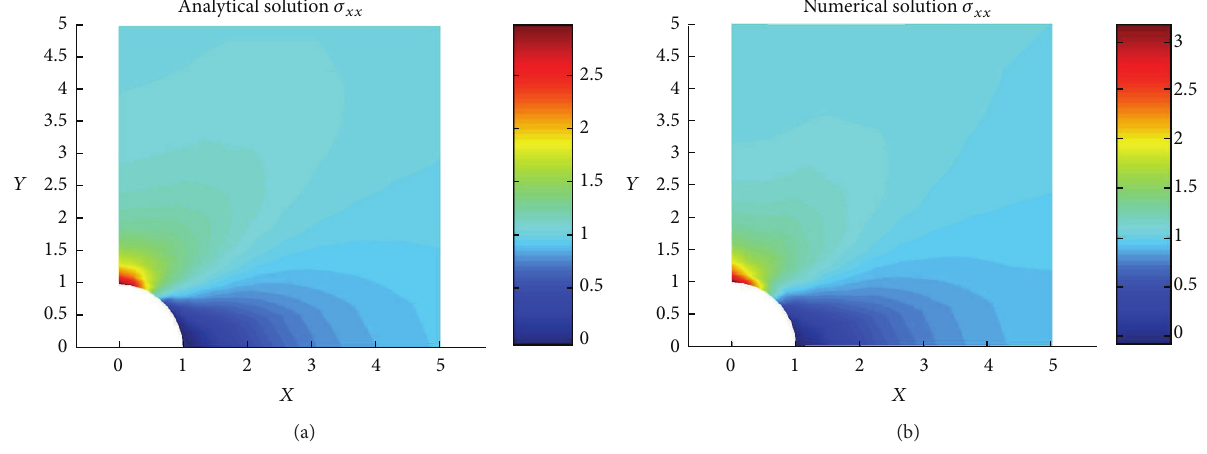
Figure 13: Stress 𝜎 𝑥 : analytical results (a) and RGD numerical results